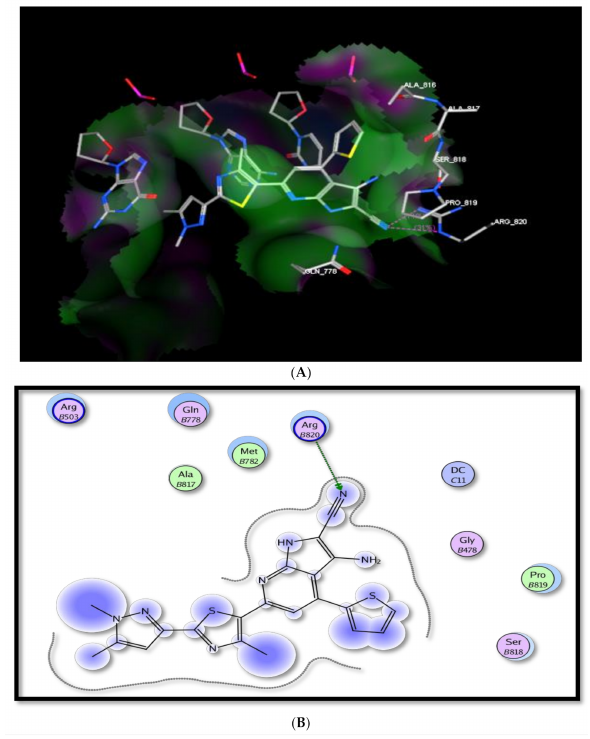
Figure 7. The suggested binding mode of compound 9 within topoisomerase II. ( A ) 3D binding mode within the active site. ( B ) 2D binding mode within topoisomerase